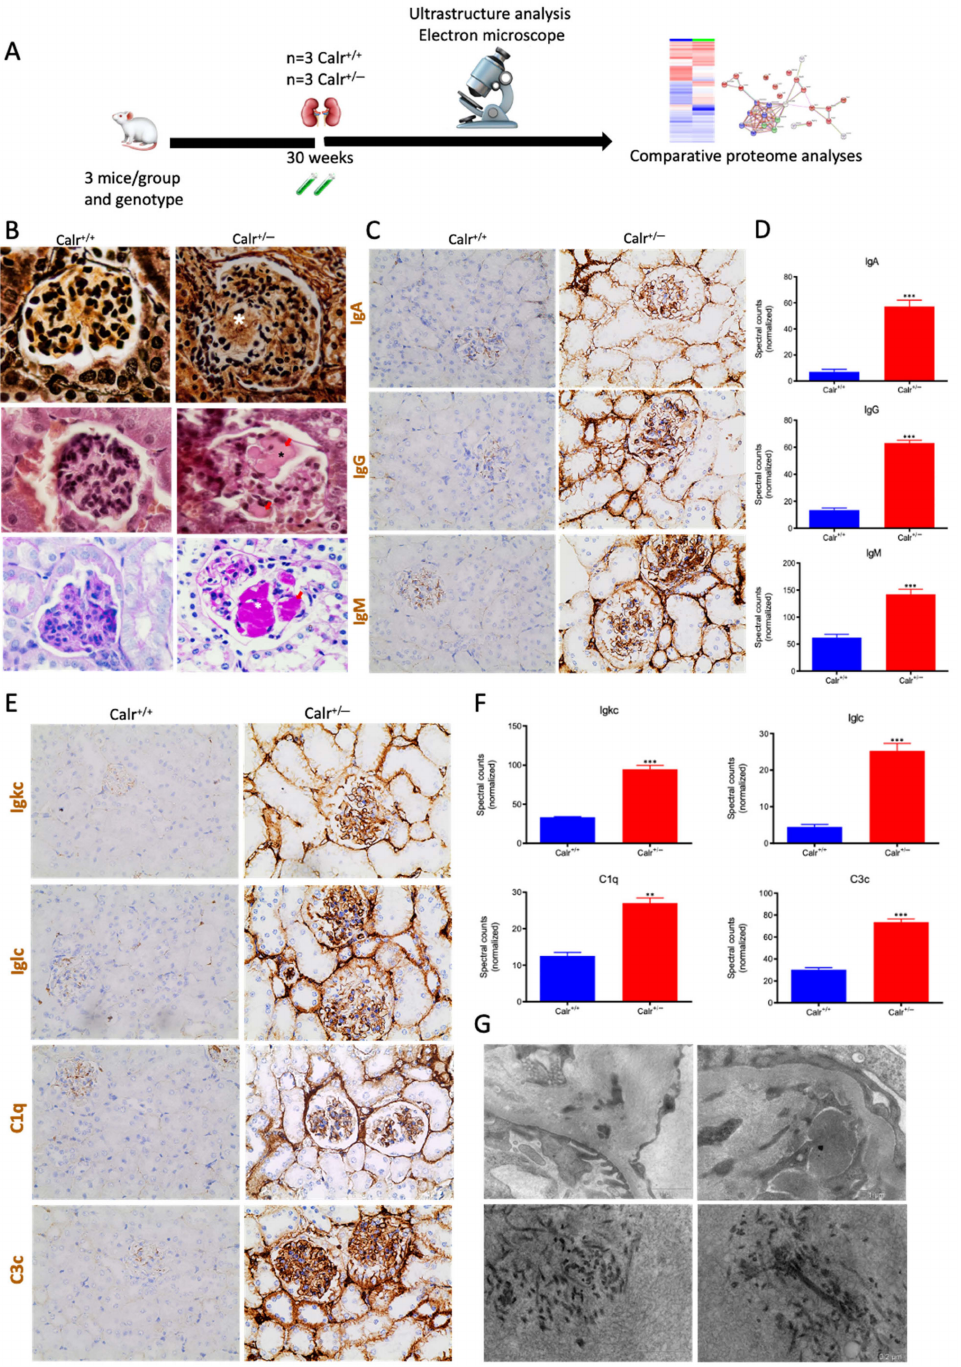
Figure 10. Calr +/ − kidney showed an anti-GBM disease. ( A ): Illustration of the experimental